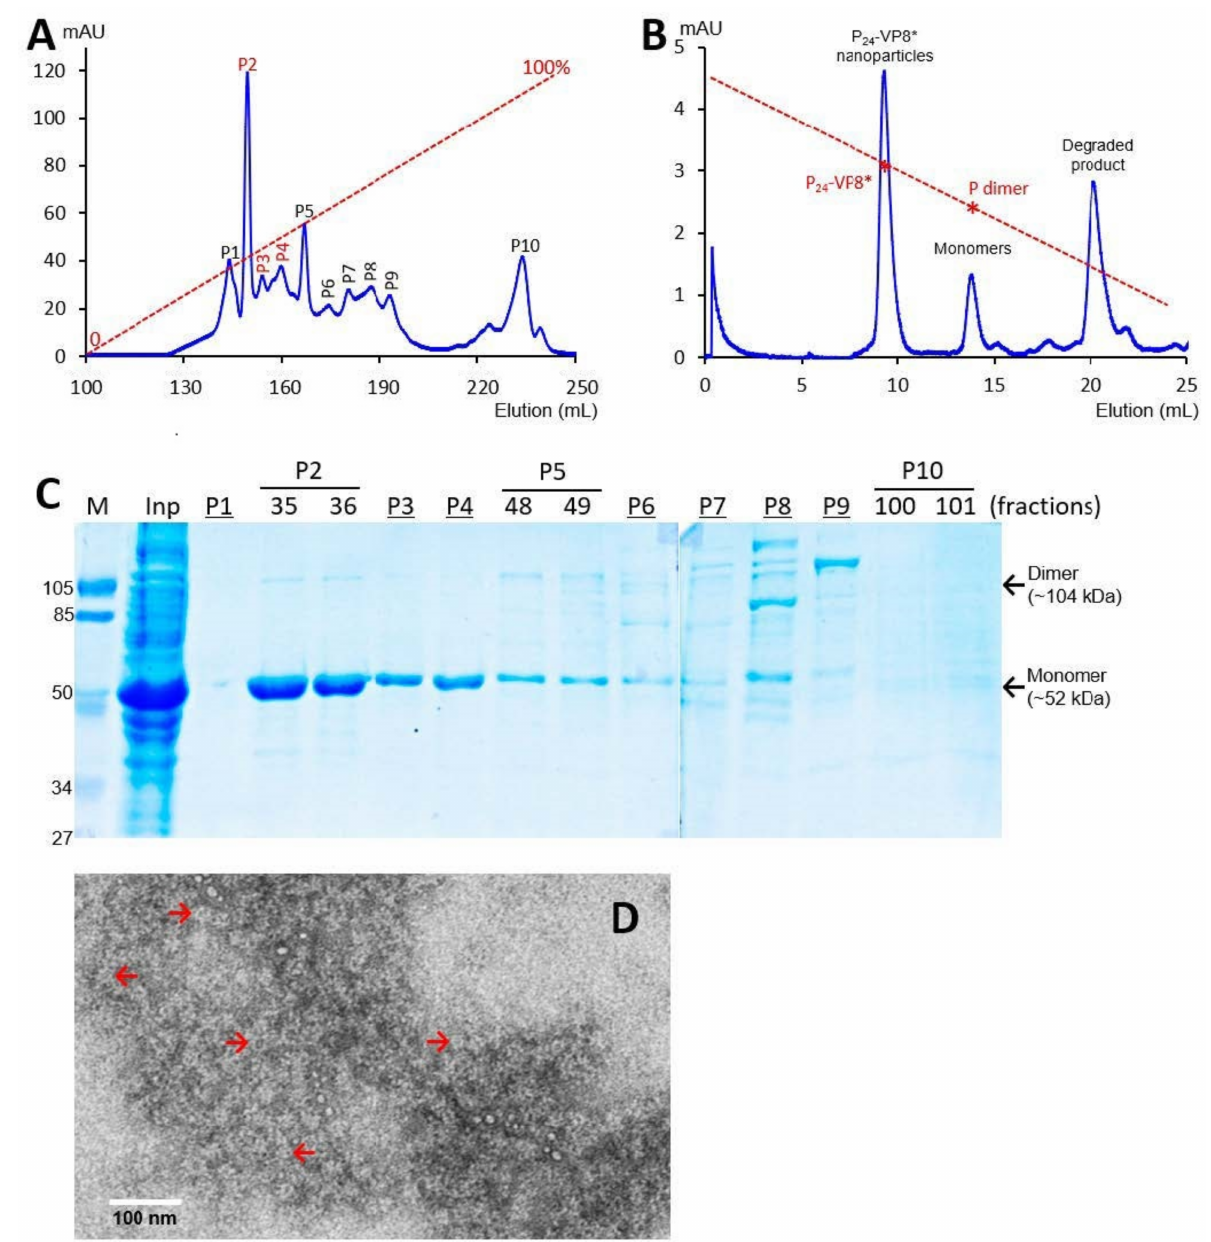
Figure 3. Production, purification, and characterization of the P-VP8* P[6] proteins. ( A ) A typical elution curve of an anion exchange chromatography of the (NH 4 ) 2 SO 4 -precipitated P-VP8* P[6] proteins, showing elution peaks of P2, P3, and P[4] containing major P-VP8* P[6] proteins. The Y-axis shows A280 absorbances (mAU), while the X-axis indicates elusion volume (mL). The red dashed line shows the linear gradient increase of the elution buffer B (0–100%). ( B ) A typical elution curve of a gel-filtration chromatography of the ion exchange-purified P-VP8* protein from P2 of ( A ) through a size exclusion column. The major P 24 -VP8* elution peak, the minor monomer peak, and a peak representing degraded proteins with small molecular sizes are indicated. The elution peaks were calibrated using the previously made P 24 -VP8* P[8] nanoparticles (~1.2 mDa) [15] and P dimers (69 kDa) [43] with their elution positions shown by star symbols on a red dashed line. The Y- and X-axes are the same as in ( A ). ( C ) SDS-PAGE of the major elution peaks and fractions showing the purified P-VP8* P[6] proteins. M, prestained protein standards with indicated molecular sizes in kDa; inp, the (NH 4 ) 2 SO 4 -precipitated proteins as input proteins. ( D ) An EM micrograph of the P-VP8*(6) proteins from the major peak of ( B ) showing typical P 24 -VP8 nanoparticles